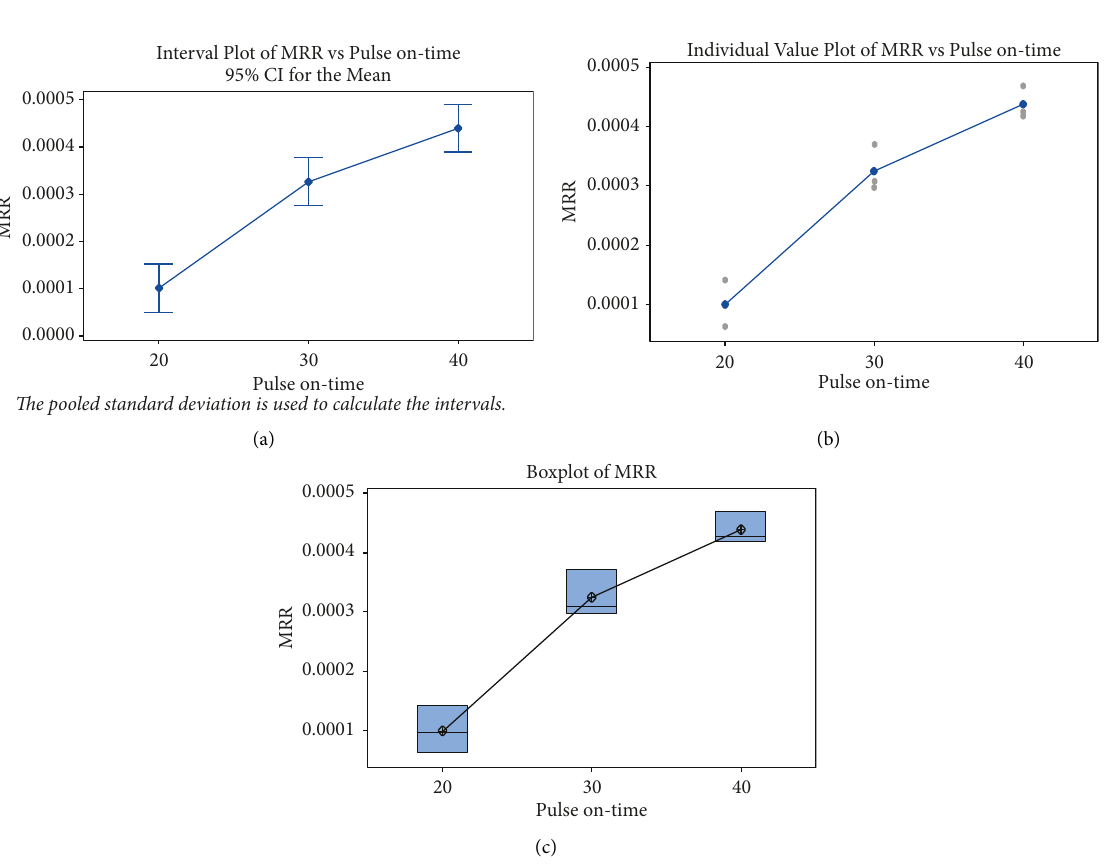
Figure 9: (a) Interval plot of MRR vs pulse-on time for mild steel. (b) Individual value plot of MRR vs pulse-on time for mild steel. (c) Boxplot of MRR vs pulse-on time for mild steel.